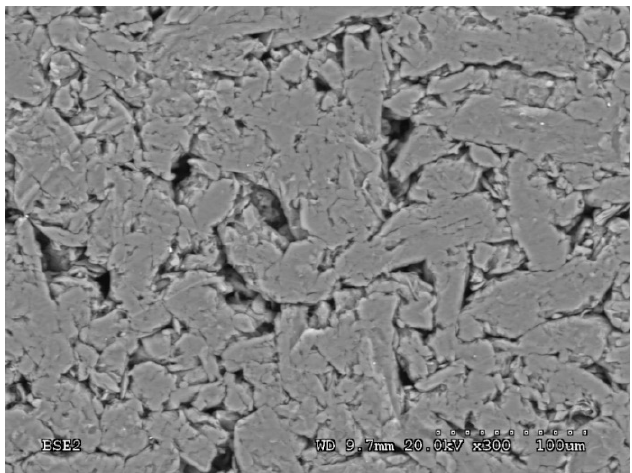
Figure 4. Surface pores’ structure of a tablet at 90% of relative density (10% porosity) of the compressed powder tablet. Image obtained via scanning electron microscopy (SEM) (S-4700, Hitachi America, Ltd., Santa Clara, CA, USA) in BSE (backscattering) mode with, respectively, 20-kV accelera- tion tension at a working distance of 9.7